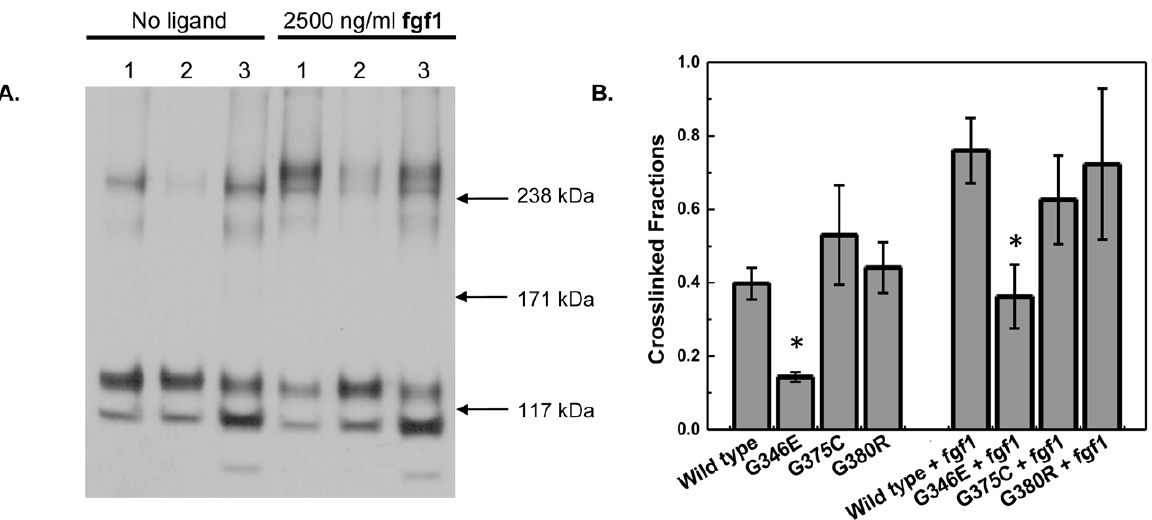
Figure 3. Effect of the achondroplasia mutations on FGFR3 cross-linking. HEK 293 cells were transfected with 2 m g DNA per well. 24 hours after transfection, cells were starved in serum-free medium for 24 hours, followed by ligand addition, BS 3 crosslinking, and lysis. A. A typical Western blot result. Lane 1: FGFR3/WT, Lane 2: FGFR3/G346E, Lane 3: FGFR3/G375C. B. Cross-linked fractions, calculated as S D /S=S D /(S M + S D ), where S D is the intensity of the cross-linked band, and S M is the intensity of the monomeric band. The stars indicate statistical significance (p , 0.01, see text).